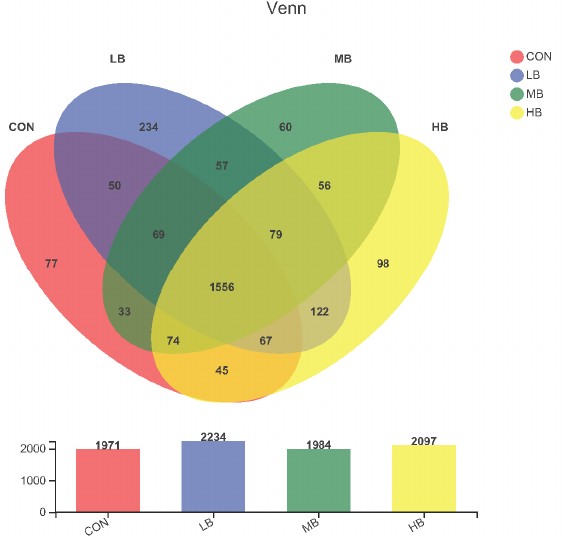
Figure 2. Venn diagram that revealing the relationship of operational taxonomic units (OTUs) of fecal bacteria in cows among treatments. Each circle represents a kind of diet. The number of OTUs shared between the corresponding groups is represented in overlapping areas; the numbers in non-overlapping areas of circles represent OTUs not shared between groups. CON (control, no by-products), low by-products (1.67%) (LB: 0.83% SH + 0.84% BP), medium by-products (3.33%) (MB: 1.67% SH + 1.66% BP), and high by-products (5%) (HB: 2.5% SH + 2.5% BP) (DM basis). In the fecal samples of all cows in four groups, we detected a total of seven bacterial phyla (Table 3); the order of decreasing relative abundance was Firmicutes (65.23– 71.10%), Bacteroidetes (19.23–23.69%), Actinobacteria (6.10–7.07%), Spirochaetes (1.11–